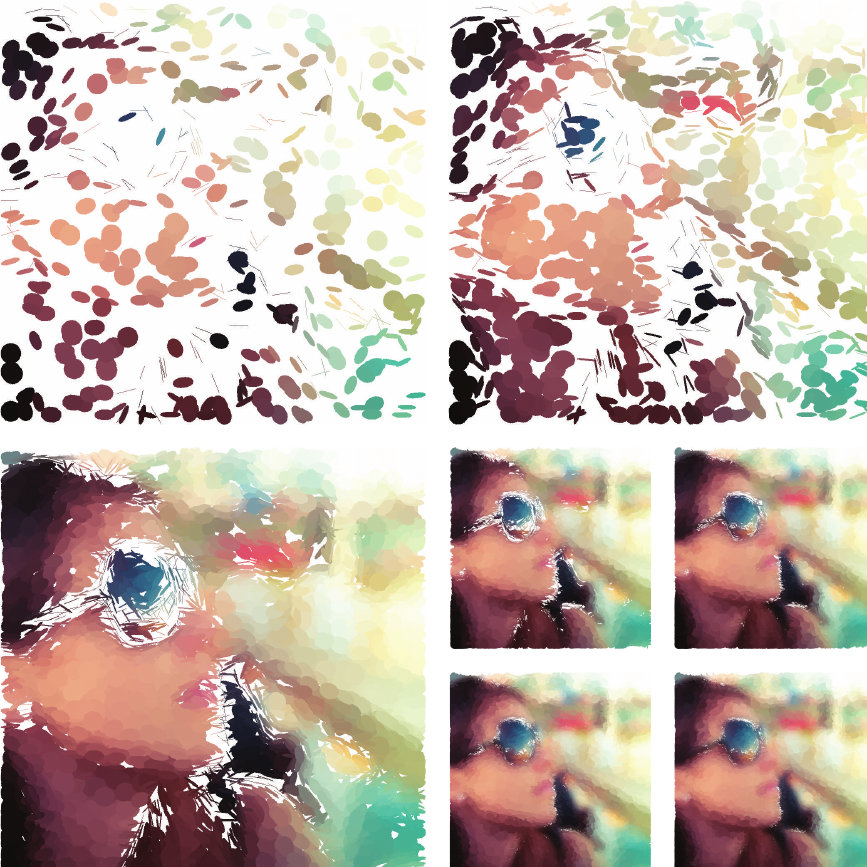
Figure 9: Pointillism results with different dot number settings from left to right, top to down: 500, 1000, 5000, 10000, 20000, 30000, and 40000 dots. The maximal and minimal dot size are 51 and 5,